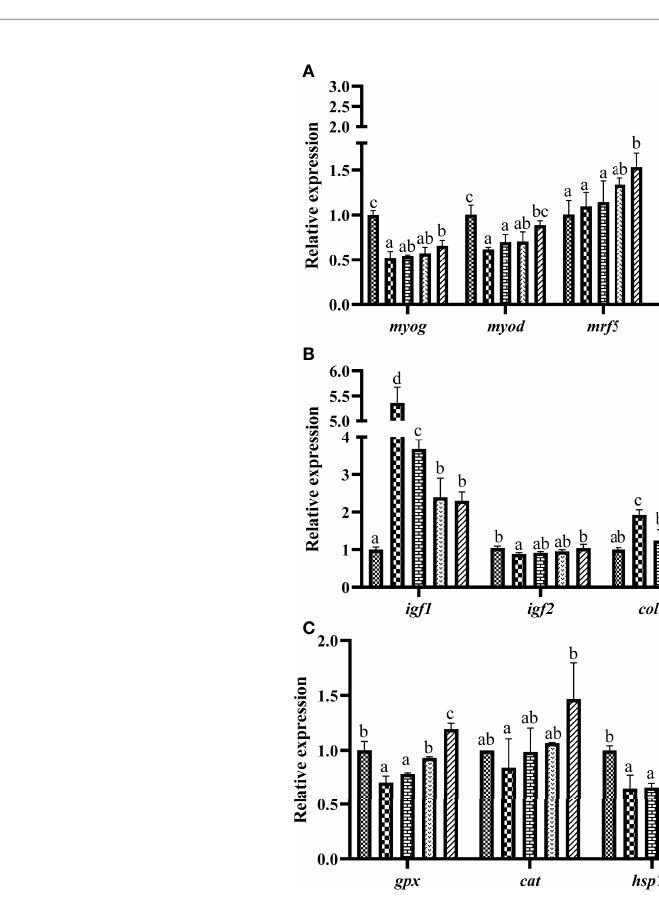
FIGURE 2 | Relative mRNA expression of muscle growth factors (A, B) and antioxidant-related genes (C) of grouper fed different diets. myog , myogenin; myod , myogenic differentiation; myf5 , myofactar5; mrf4 , myogenic regulatory factor 4; mstn2 , myostatin type 2; igf1 , insulin-like growth factor 1; igf2 , insulin-like growth factor 2; col1a1 , collagen type I alpha1; col1a2 , collagen type I alpha2; cat , catalase; gpx , glutathione peroxidase; hsp70 , heat shock protein 70; hsp90 , heat shock protein 90. Different lowercase letters represent signi fi cant differences between groups (P <